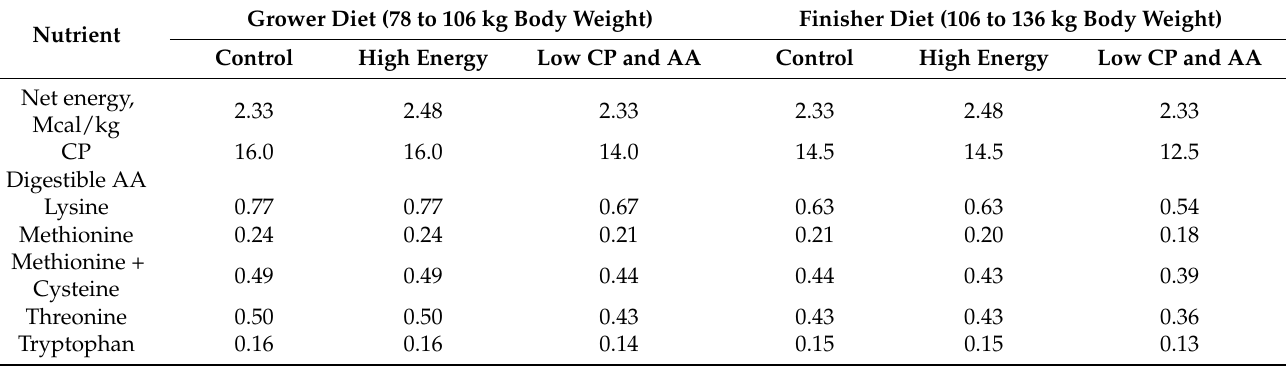
Table 2. Estimated nutrient composition of the tested diets (%, as-fed